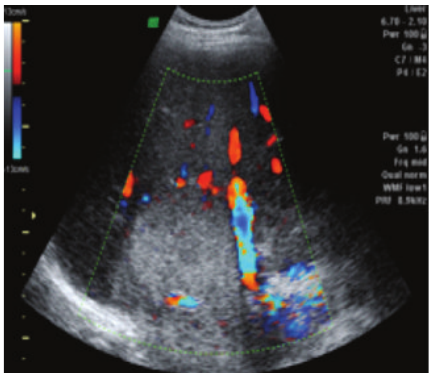
Figure 5: On noncontrast CT phase lesion was poorly visualized, shaped as a flower with a lower density than liver parenchyma.